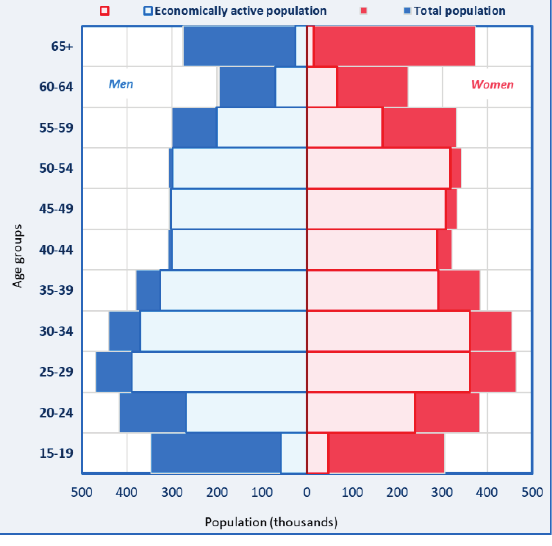
Figure 27. Sex and age structure of the population older than 15 years and of the economically active population of Azerbaijan as of 01.01.2018. Source: according to SSC